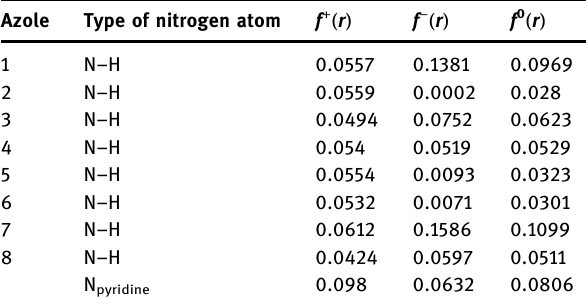
Table 2: Computed condensed Fukui function values ( a.u. ) for nucleophilic ( f + ( r )) , electrophilic ( f − ( r )) , and radical ( f 0 ( r )) attack for azoles 1 – 8 ( B3LYP/6 - 311 ++ G ( 2d,3p ) //B3LYP - 631G ( d,p ) ; gaseous phase ) ; N – H ( pyrrolic type of nitrogen atom ) , N pyridine ( endocyclic pyridinic nitrogen atom within azole 8 ) .